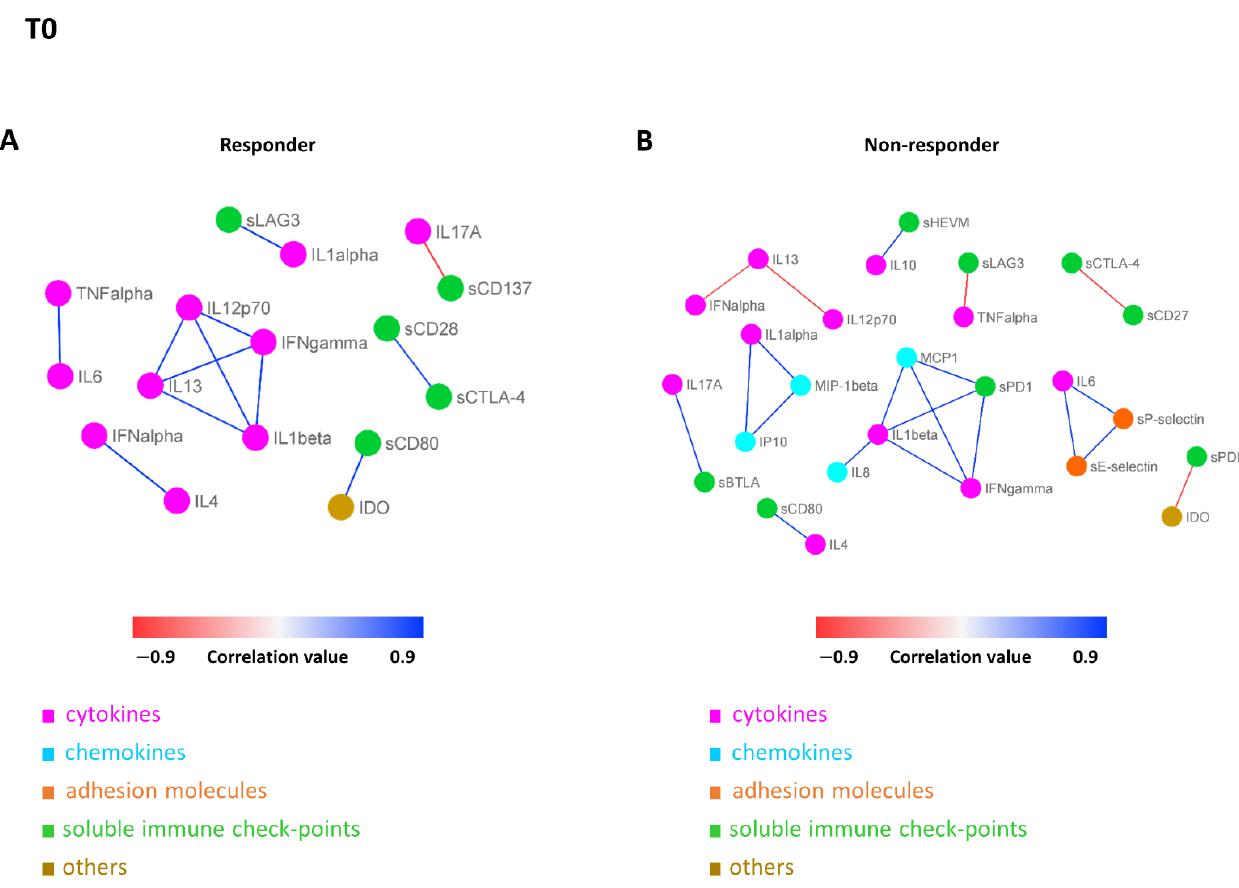
Figure 6. Connectivity network between molecules in responder ( A ) and non-responder ( B ) patients at T0. In each network, nodes represent molecule, and a link occurs between two nodes if the absolute value of Spearman correlation between their expression levels is statistically significant ( p -value ≤ 0.05) and greater than a selected threshold (i.e., the 85th percentile of the overall distribution corresponding to 0.8). Nodes are colored according to the functional groups reported in the legend, whereas edge colour indicates positive (blue) or negative (red) correlation values.